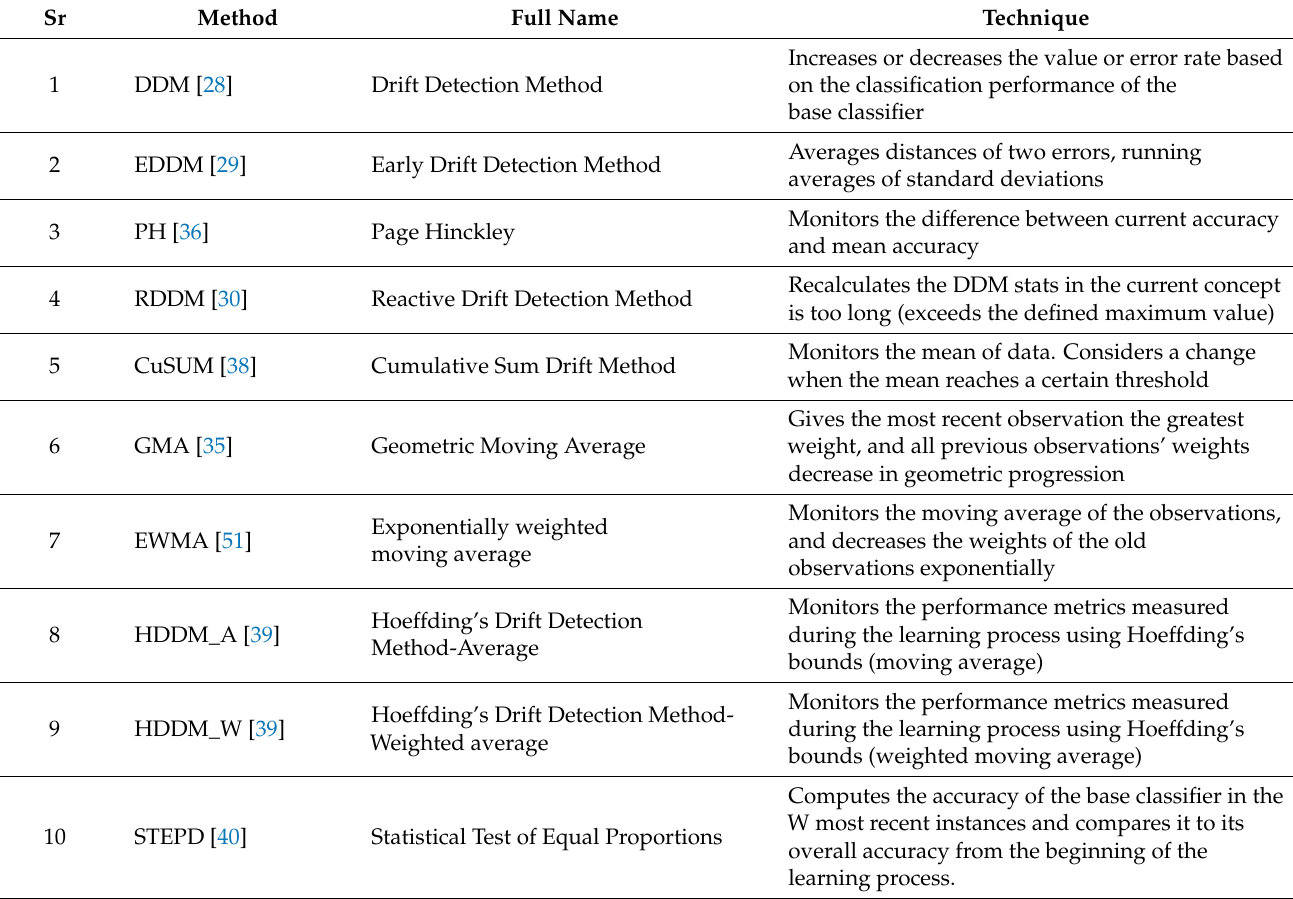
Table 3. Summary of drift detection methods considered for